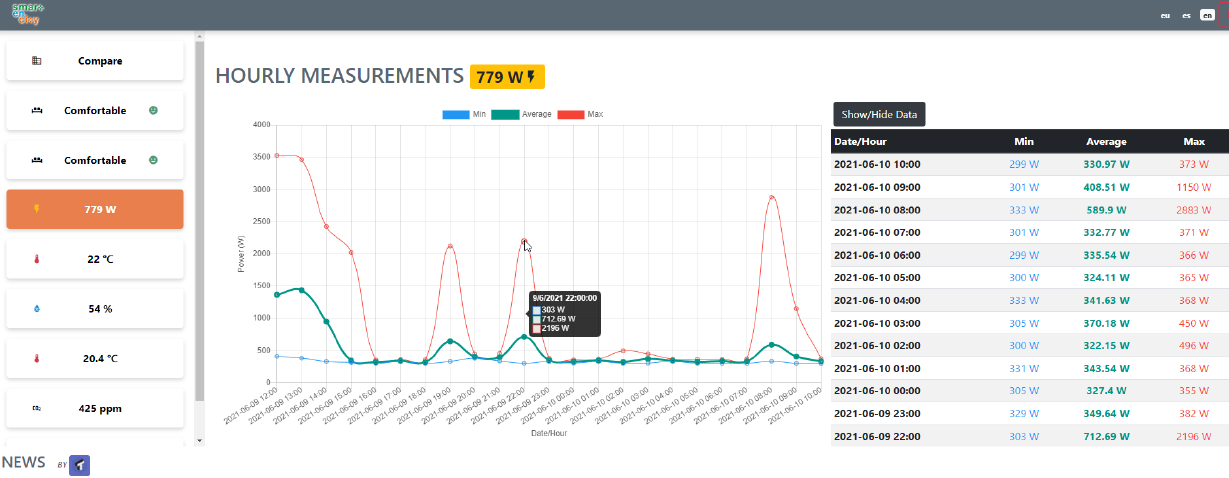
Figure 9. Dwelling Conditions Monitoring